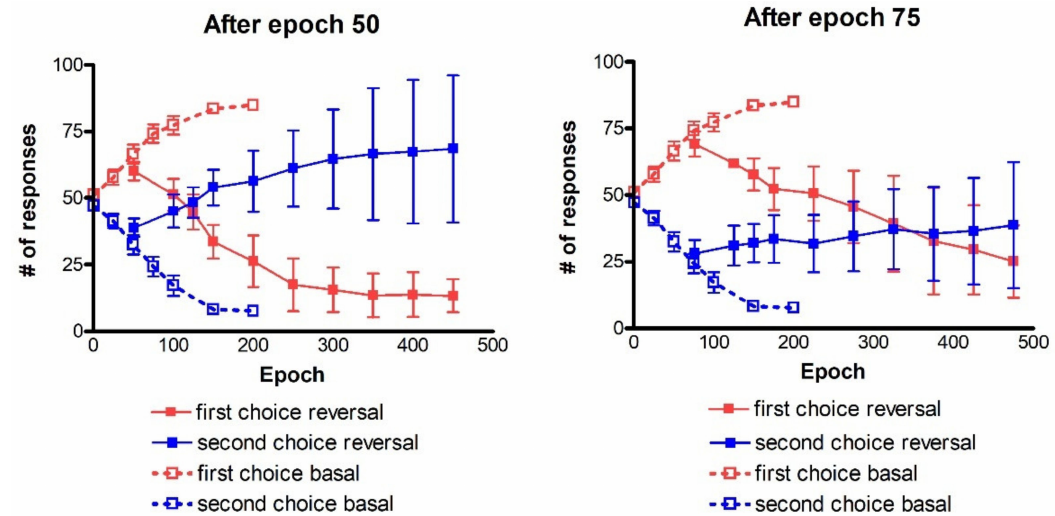
Figure 6. Temporal pattern of the responses in the test trials when the reversal learning is performed after 50 epochs of previous basal training (left panel) and after 75 epochs (right panel). All results refer to the post-post rule. The dashed dotted lines with open squares represent the results of the previous basal training (the same results as in the left panel of Figure 2). The continuous lines with filled squares represent the results of the reversal learning phase. All points are the results of 100 test trials, performed by using the synapses obtained at the given instant. The phasic dopaminergic drop was 0.5 in the basal training, 1.0 in the reversal training performed after 50 epochs, and 1.5 in the reversal training performed after 100 epochs. It is worth noting that the term “first choice” refers to the actions more often rewarded during the basal training with a given stimulus, which becomes more often punished during the